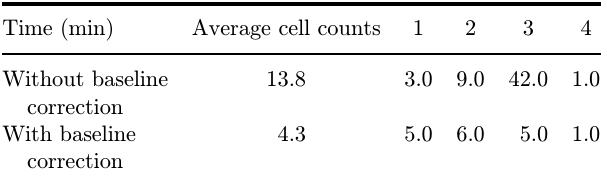
Table 2. Cell count results for a signal with gentle baseline °uctuation.